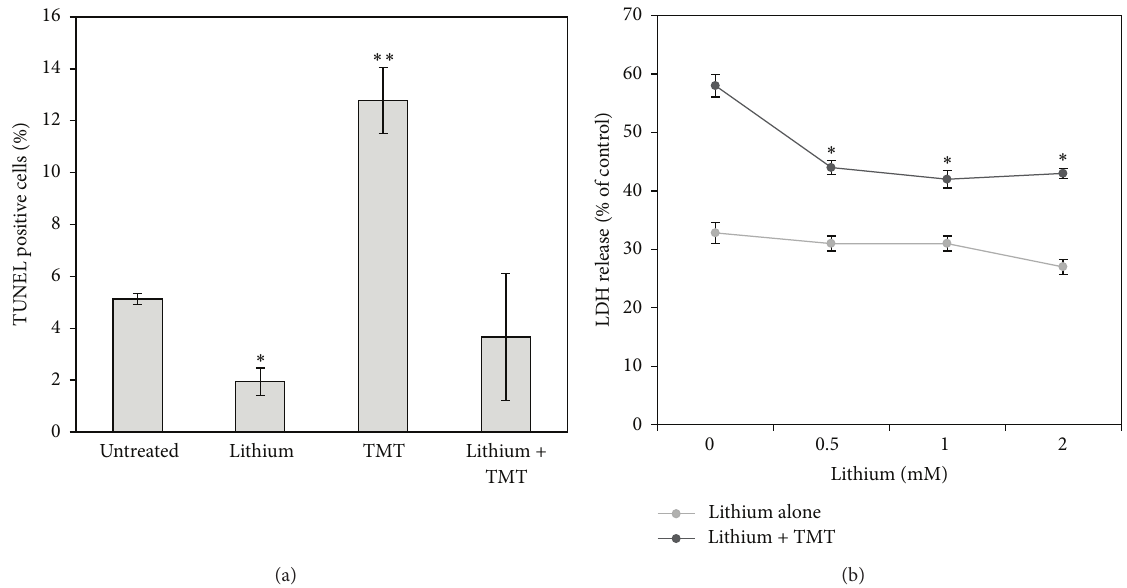
Figure 3: Detection of TUNEL-positive cells (a) and release of LDH (b) in the culture medium of PC12 cells treated for 24 and 48 hours, respectively, with 10 𝜇 M TMT alone or in combination with 0.5 mM lithium. Lithium treatment completely reverses TMT-induced apoptosis (a); a significant inhibition of LDH release is observed in PC12 cells treated with doses of lithium ranging from 0.5 to 2 mM with respect to cultures treated with TMT alone. Averages ± SEM of three independent experiments. ANOVA with Bonferroni’s-corrected 𝑡 -test. ∗ 𝑃 < 0.01 , ∗∗ 𝑃 < 0.001 versus untreated control.